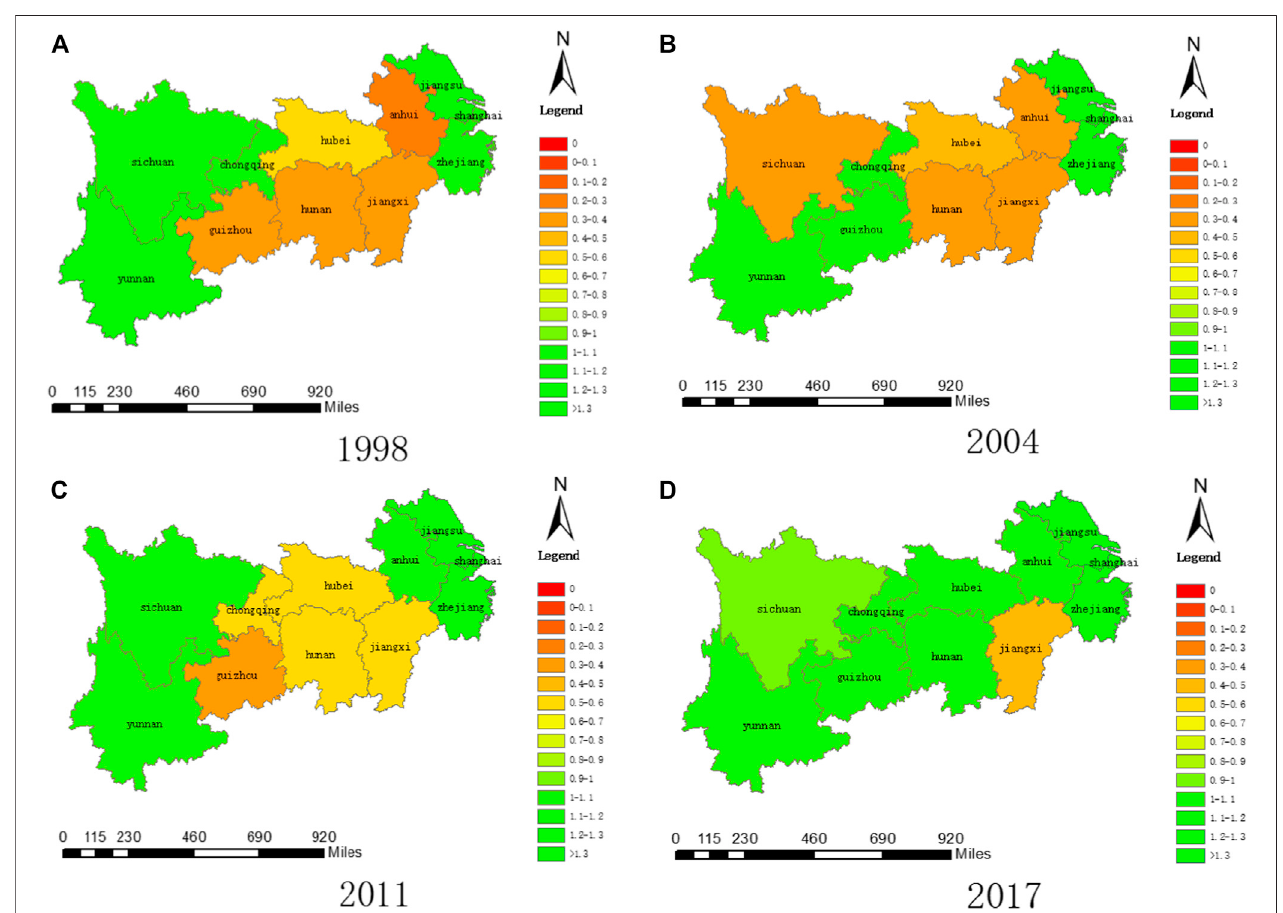
FIGURE 2 | Manufacturing green development ef fi ciency in 1998, 2004, 2011 and 2017.